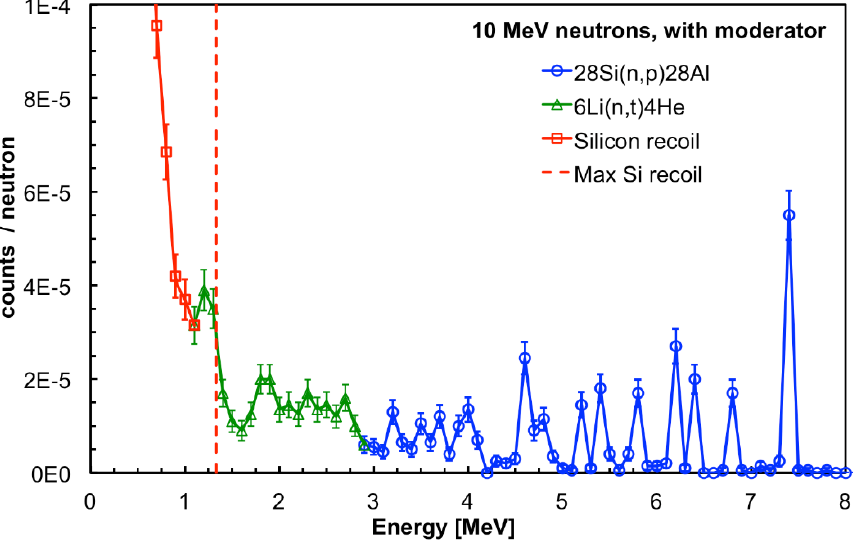
Figure 12. GEANT4 simulation of the SiLiF response to 10 MeV neutrons with the moderator surrounding the detector (see text).